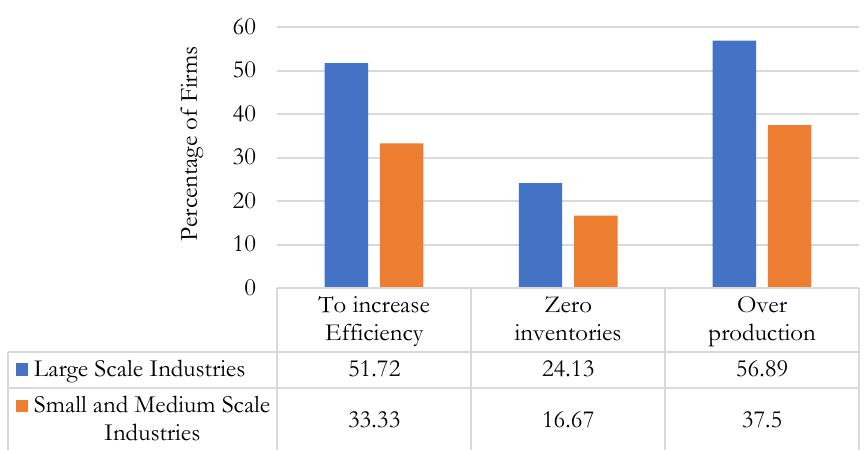
Fig. 4. Comparison of JIT tools between two groups.